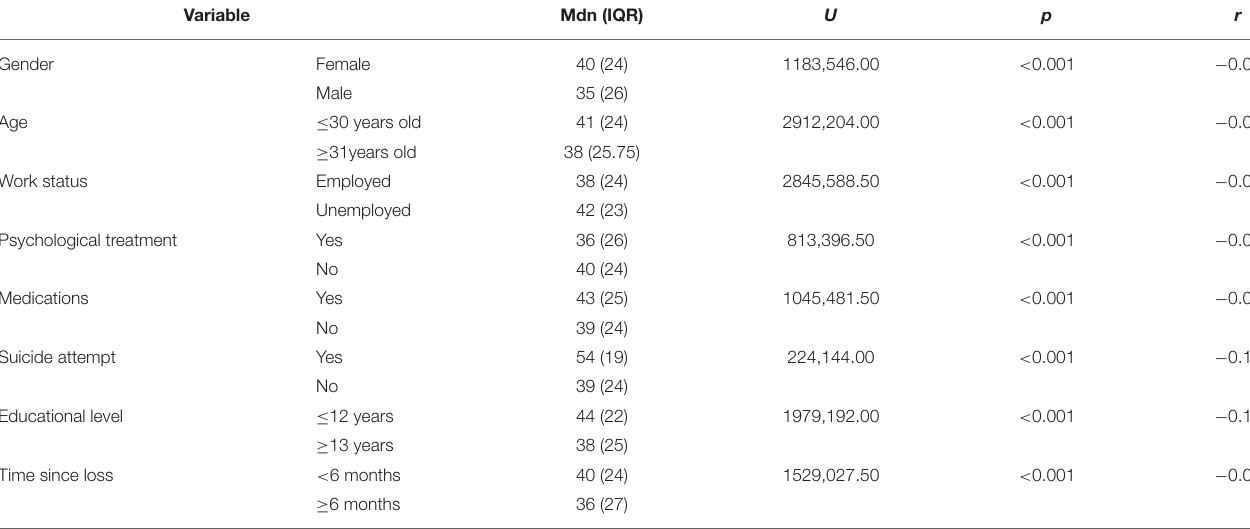
TABLE 2 | Levels of complicated grief symptoms by